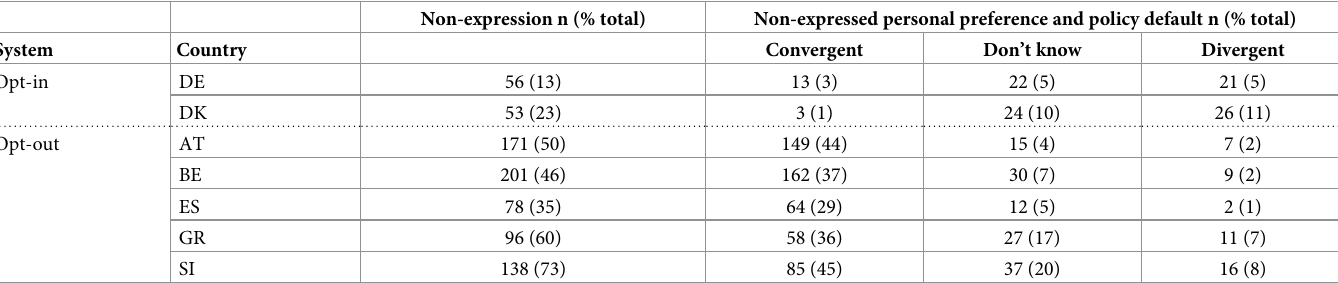
Table 6. Risk of contravening non-expressed preferences: Total frequency, and convergence with default, by country. Non-expression n (%